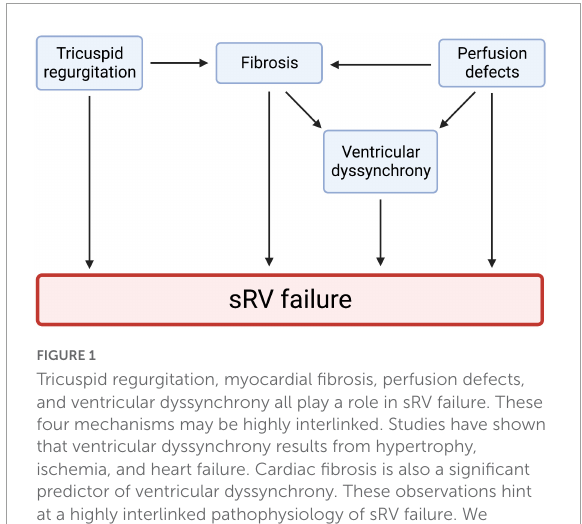
FIGURE1 Tricuspid regurgitation, myocardial fibrosis, perfusion defects, and ventricular dyssynchrony all play a role in sRV failure. These four mechanisms may be highly interlinked. Studies have shown that ventricular dyssynchrony results from hypertrophy, ischemia, and heart failure. Cardiac fibrosis is also a significant predictor of ventricular dyssynchrony. These observations hint at a highly interlinked pathophysiology of sRV failure. We created the figure with